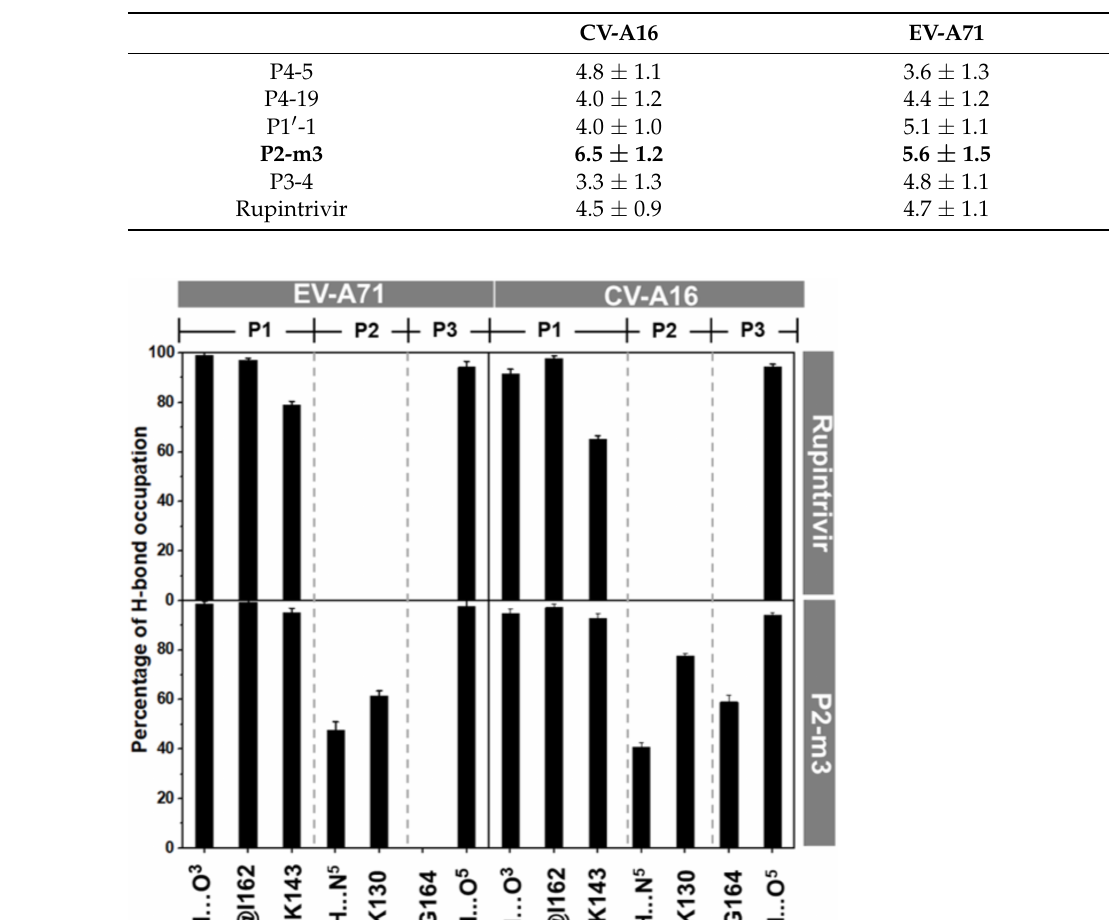
Table 3. Number of hydrogen bonds of the focused compounds with CV-A16 and EV-A71 3Cpro calculated from the last 50 ns of the three independent simulations.